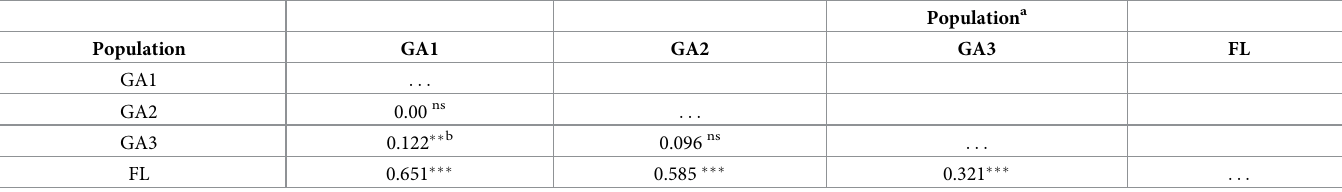
Table 5. Geographical population structure measured by Ф PT between Fusarium oxysporum f. sp. niveum populations in the southeastern United States.